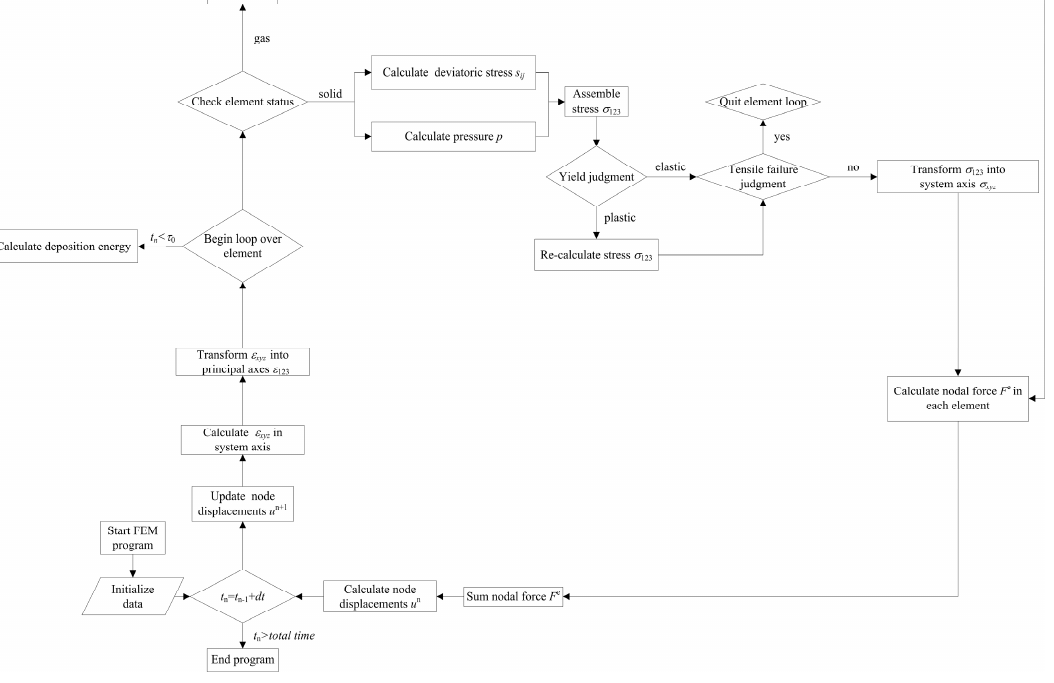
Figure 3. Flow chart of the finite element model (FEM) program.